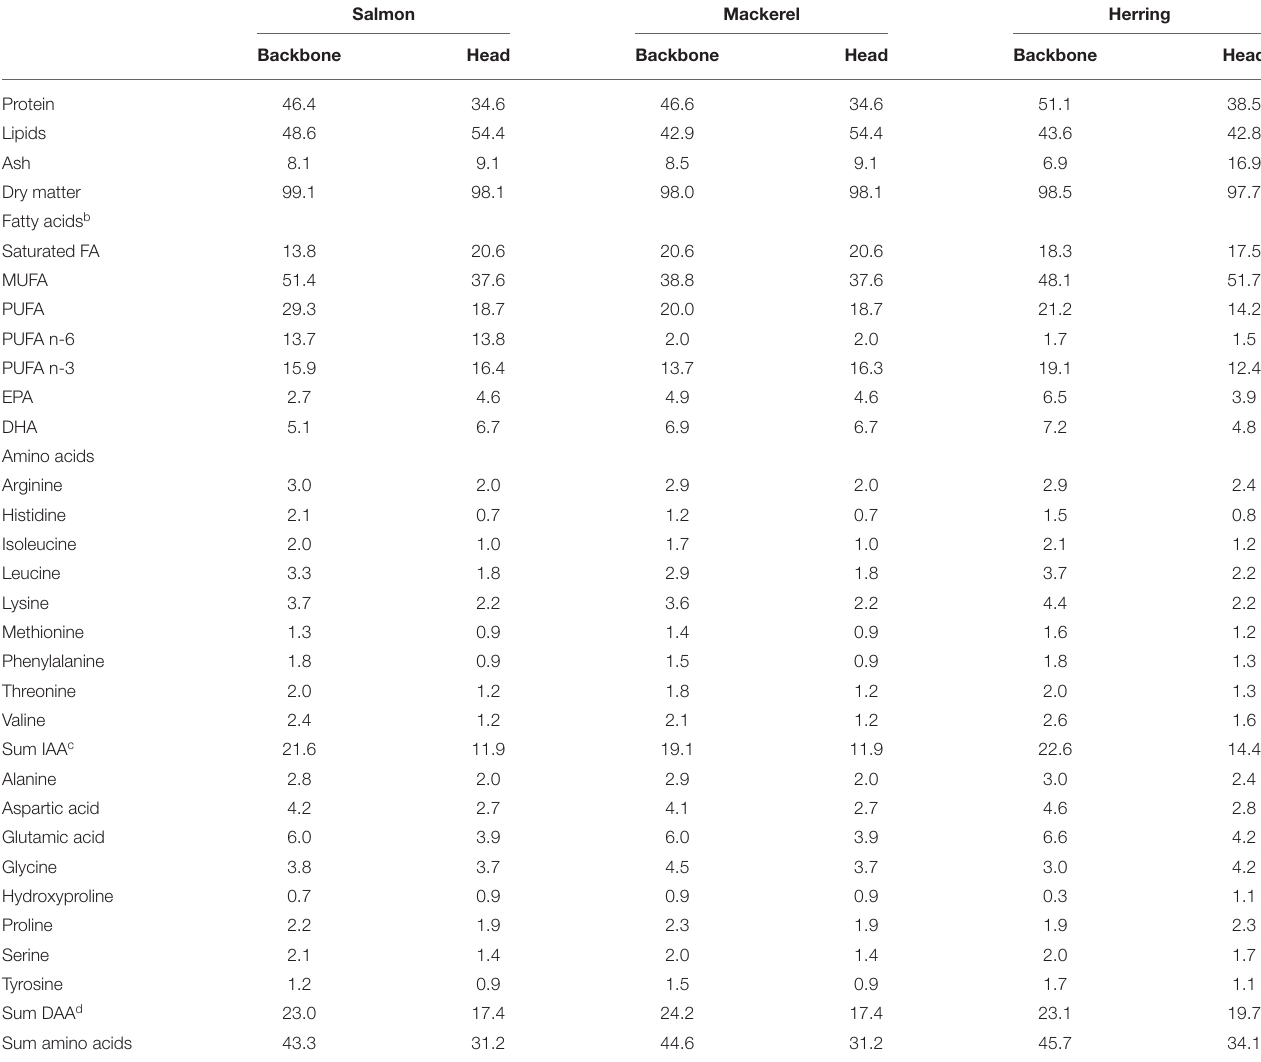
TABLE 2 | Proximate, lipid, and amino acid composition (g/100g sample) of freeze-dried heads and backbones from salmon, mackerel, and herring a . Salmon Mackerel Herring Backbone Head Backbone Head Backbone Head Protein